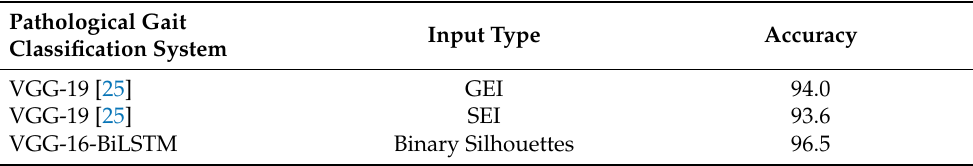
Table 2. Cross-validation average accuracy results (%) on the GAIT-IT dataset: comparison against a state-of-the-art solution using a VGG-19 CNN with the GEI or SEI gait representations. Pathological